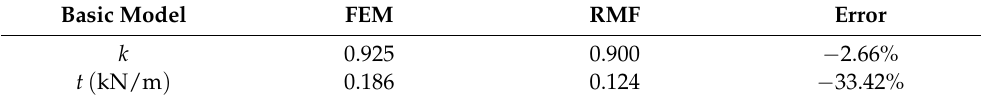
Table 1. Comparison of the finite element method (FEM) and Ritz method formulas (RMF).